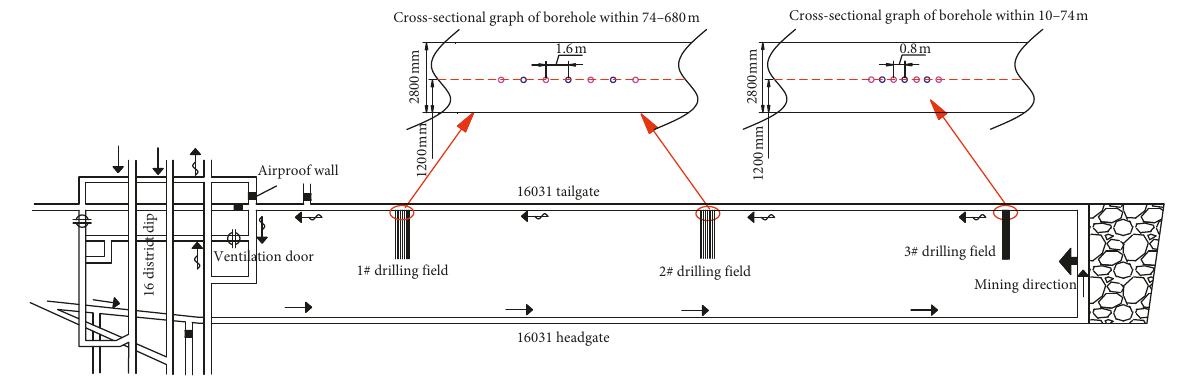
Figure 1: Location of 16031 tailgate and drilling layout.